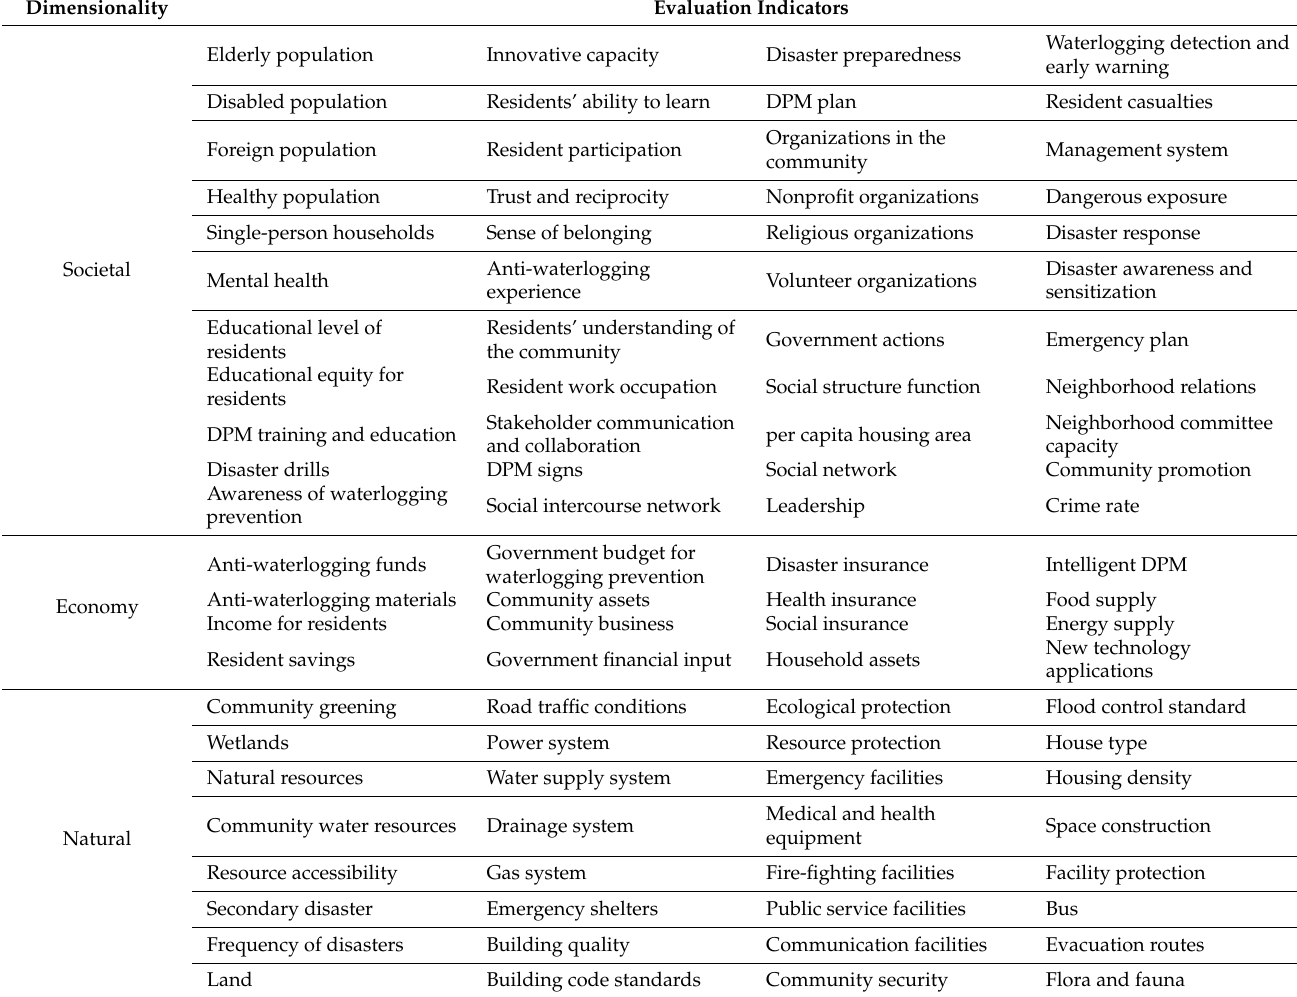
Table 2. Initial summary of community waterlogging-resilience